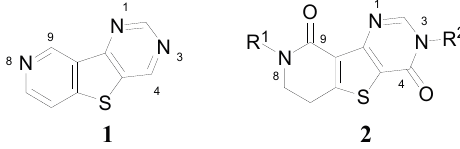
Figure 2. Pyridothienopyrimidine ( 1 ) and dihydropyridothienopyrimidin-4,9-diones 2